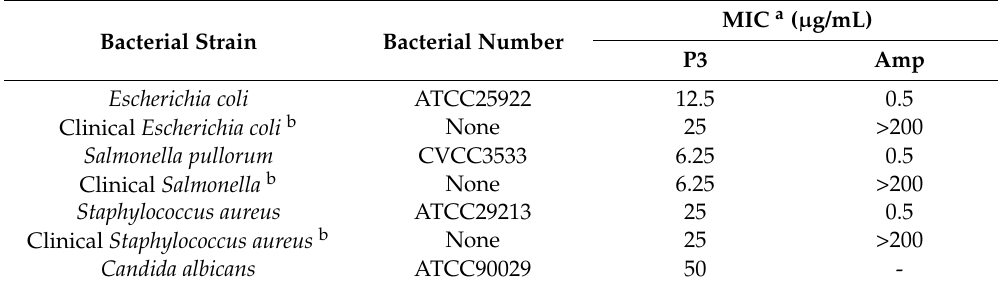
Table 1. Summary of the minimum inhibitory concentration (MIC) values of HJH-1 against all tested bacterial strains. Results represent